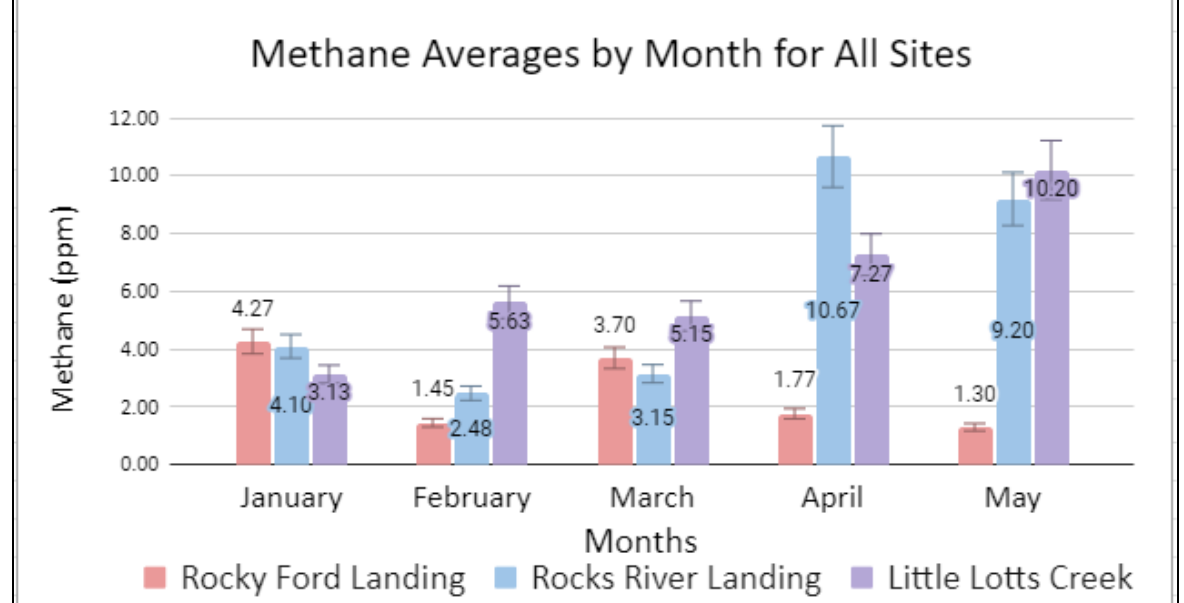
Figure 4. Air Quality — Methane (CH 4 ) Gas Sample Measurements.